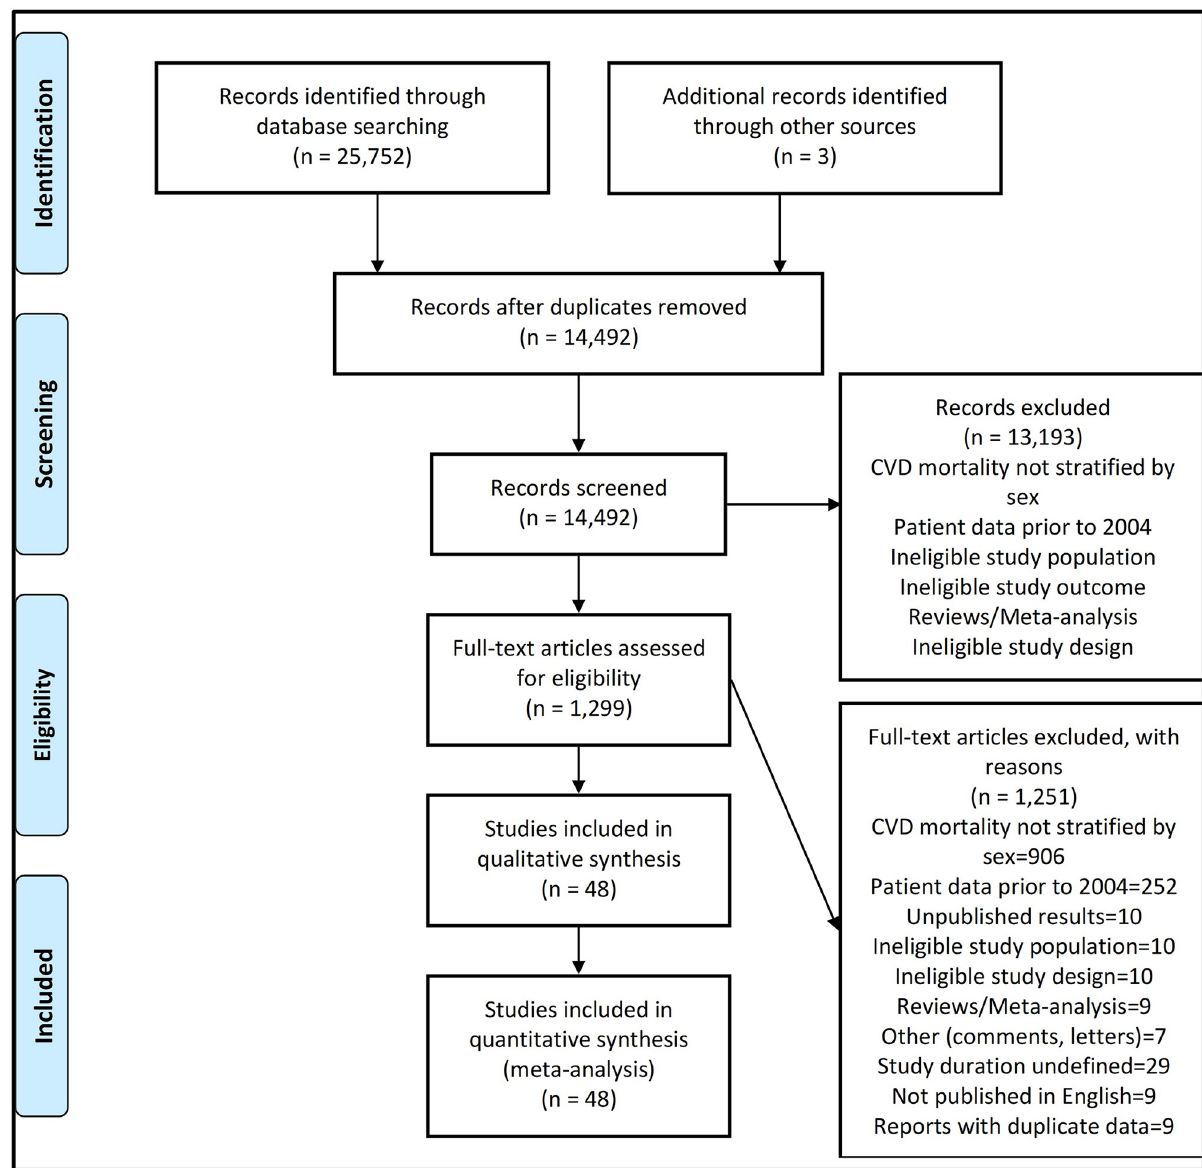
Fig 1. Flow diagram of study selection and search results. n, number of studies. CVD, Cardiovascular disease.